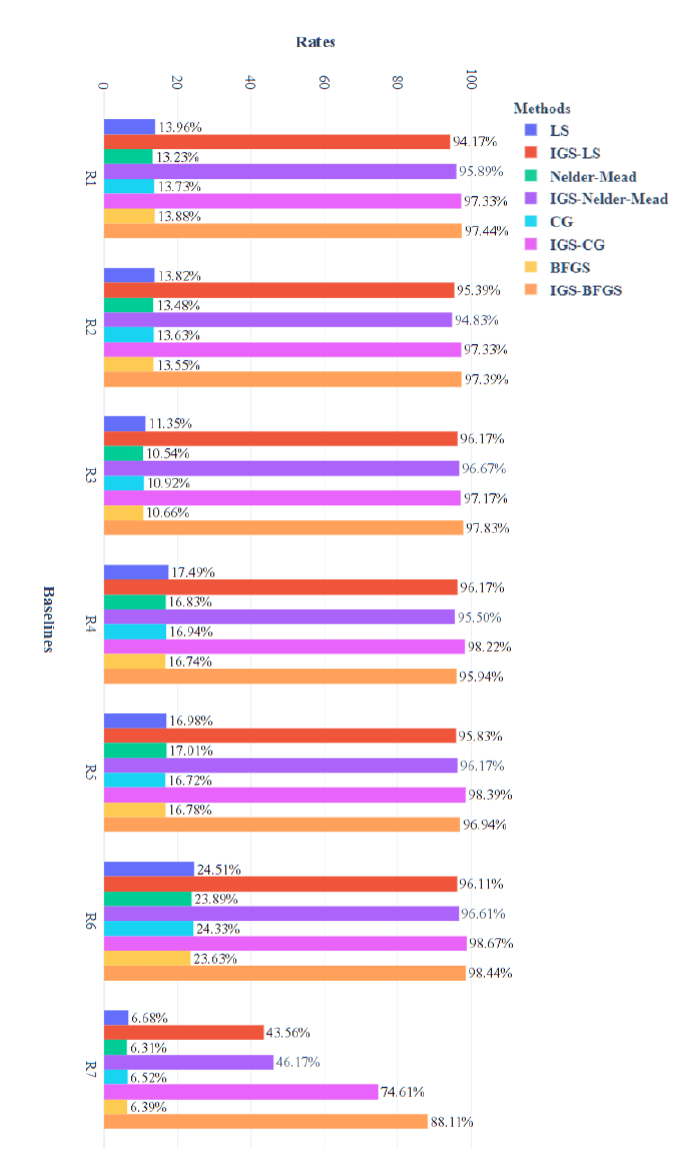
Figure 7. Reducing rates (ACC%) of unwrapped phase L1 difference less than π